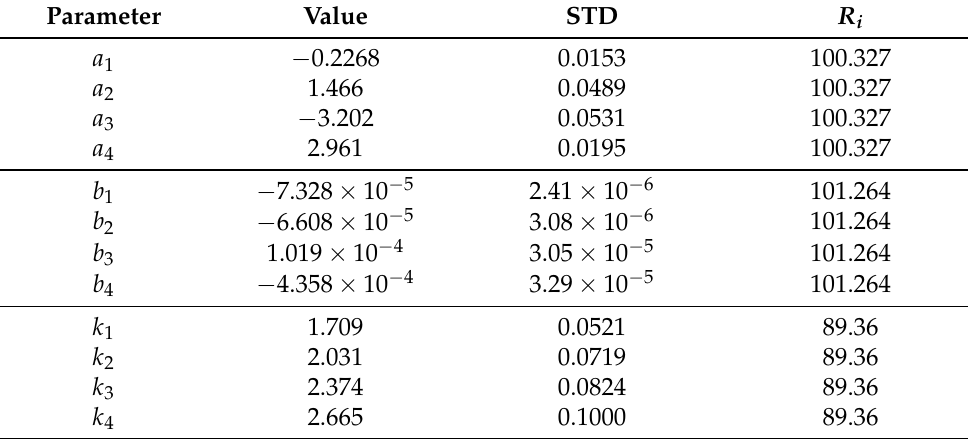
Table 3. Example of GA tuned model parameters and their STD values.